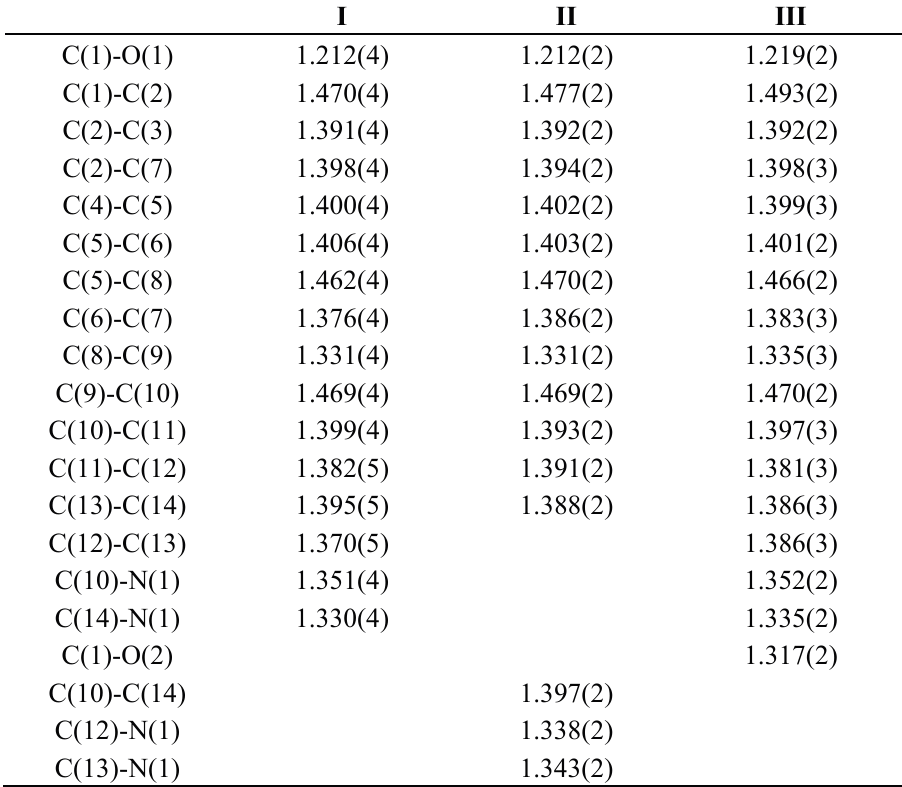
Table 2. Bond lengths (Å) for compounds I , II and III